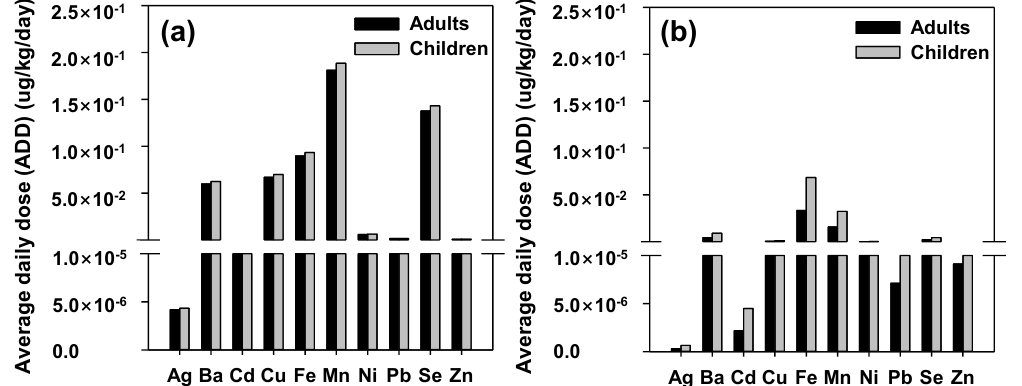
Figure 4. Average daily dose (ADD) for both ( a ) ingestion rate and ( b ) dermal adsorption of adults and children in the Han River watershed.